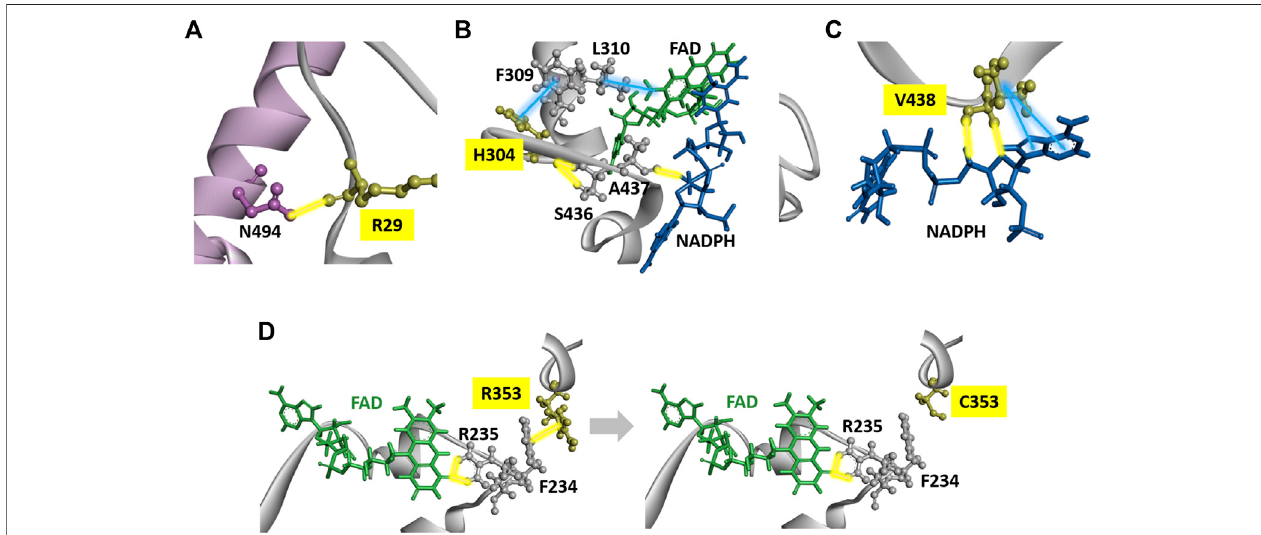
FIGURE6| DPDstructuralanalysis. (A) DiagramofafragmentofthecrystalstructuresoftheH25Rvariant.TheR25residuesareshowninyellow. (B) Diagramofa fragment of the crystal structures of the H304Y variant. The Y304 residues are shown in yellow. (C) Diagram of a fragment of the crystal structures of the F438V variant. The F438 residues are shown in yellow. (D) Diagrams of a fragment of the crystal structures of wild-type DPD (left panel) and R353C (right panel). The R353 and C353 residues are shown in yellow. Yellow and blue lines indicate hydrogen bonds and hydrophobic interactions, respectively.